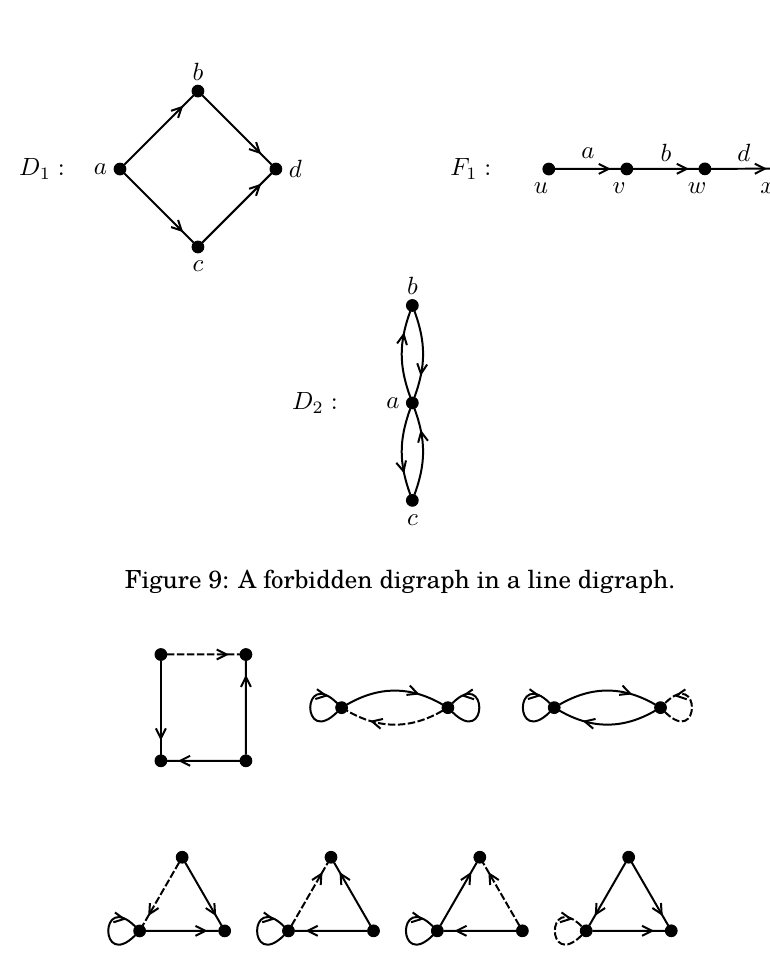
Figure 10: Seven forbidden induced subdigraphs.